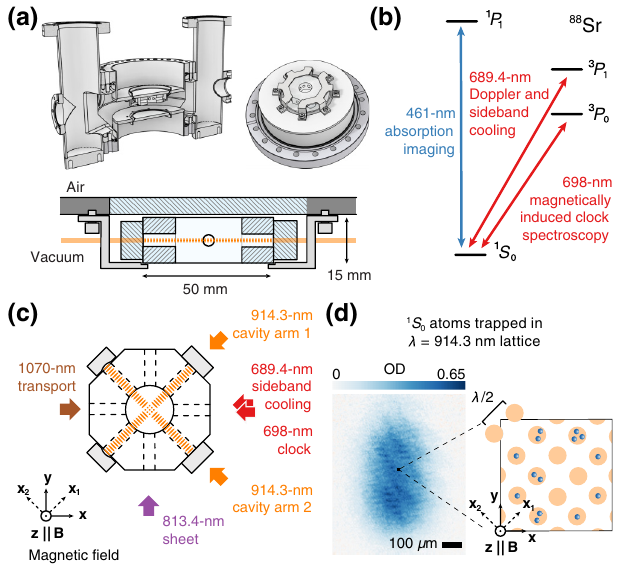
FIG. 2. An overview of the experimental setup. (a) A cross section of the science chamber, which includes a pair of reentrant view ports (top left). The cavity assembly rests in a stainless- steel cage attached to the top view port (top right). A simplified cross-section cut of the cavity assembly and its mounting struc- ture is shown at the bottom. (b) A simplified 88 Sr energy diagram and the optical transitions used in the experiment. (c) A sketch of the laboratory and lattice coordinate frames and the relevant laser beams. 88 Sr atoms in the 1 S 0 ( g ) state are transported into the assembly and are loaded into a trap created by the 914.3-nm cavity-lattice beams and a light sheet at 813.4 nm. The laser beam at 689.4 nm is used for direct sideband cooling and the laser beam at 698 nm drives the clock transition induced by a bias magnetic field B along z . (d) An in situ absorption image of g atoms in the combined trap of the lattices and light sheet (left). On the right is an illustration showing the atoms occupying the lattice